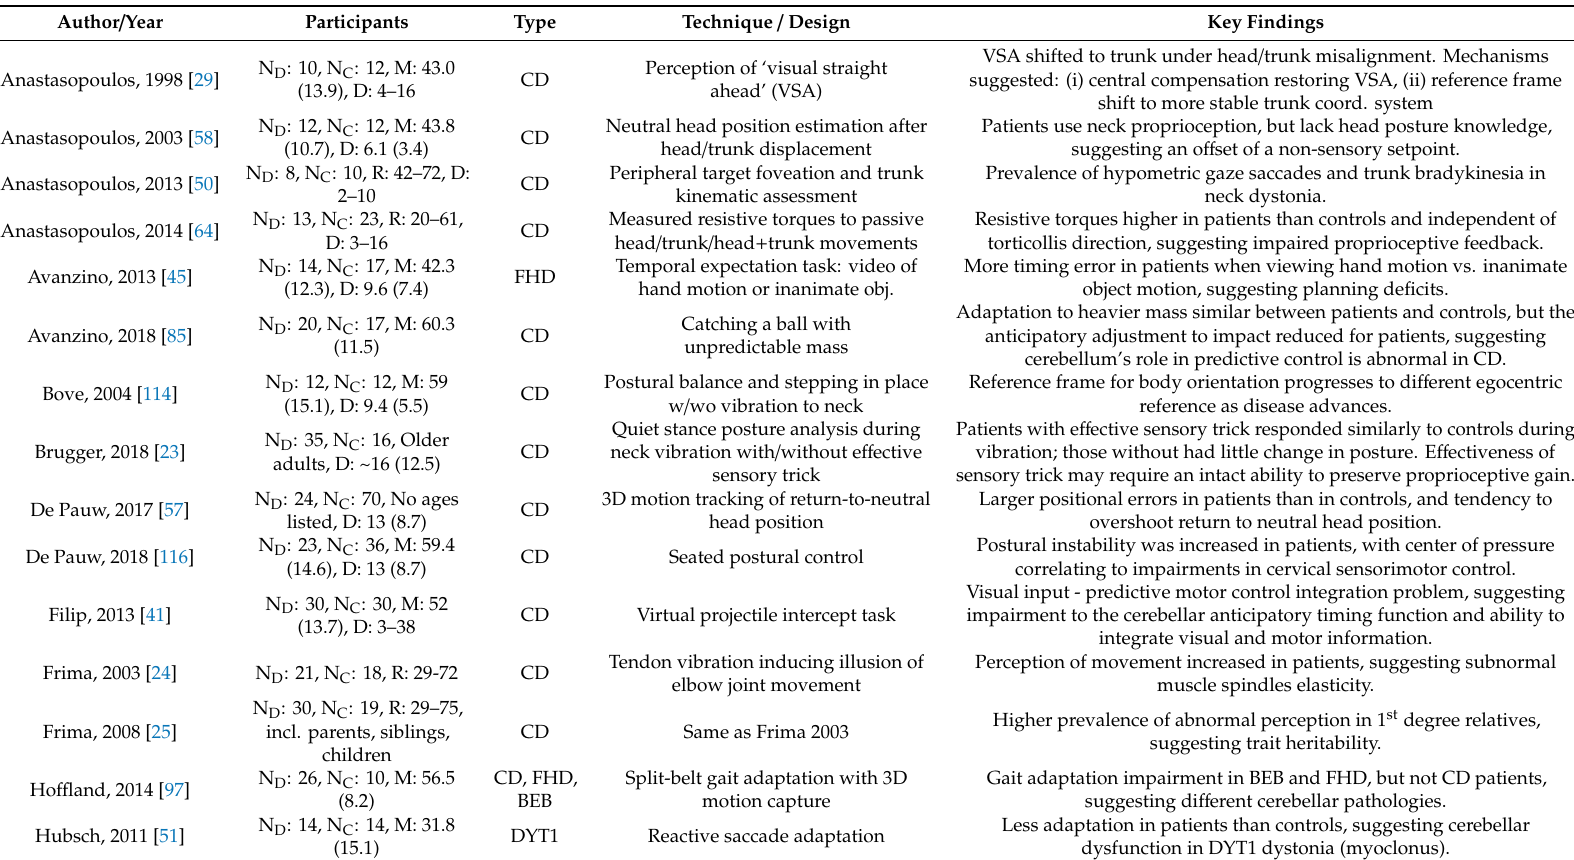
Table 1. References addressing sensorimotor integration in patients with cervical dystonia (CD), focal hand dystonia (FHD), benign essential blepharospasm (BEB), and DYT1 dystonia (DYT1). The number after the year reflects position in the reference list. Under Participants, N D , N C , and N O respectively denote dystonia, control, and other non-dystonic movement disorder sample sizes, R denotes age range, M denotes mean (standard deviation), and D denotes duration of symptoms, all in years. Key